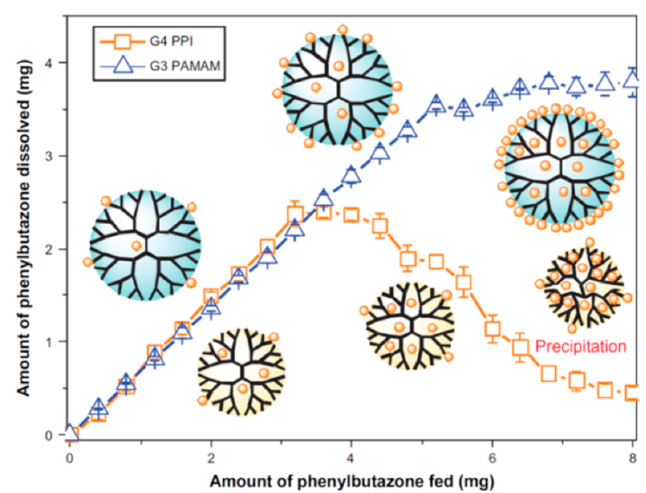
Figure 23. Comparison of drug-loading ability of G3, poly(amidoamine) (PAMAM) and G3, poly(propyleneimine) (PPI) dendrimers using a gradient feed method. Reprinted with